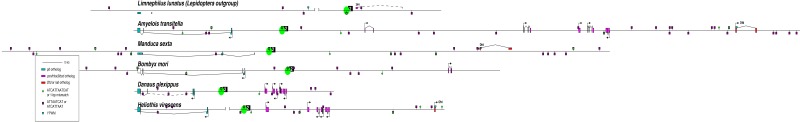
A motif upstream of pb (2) is conserved in Lepidoptera.Note that for most species many of the Shx (zen homolog) gene duplications are not shown (Ferguson et al., 2014).